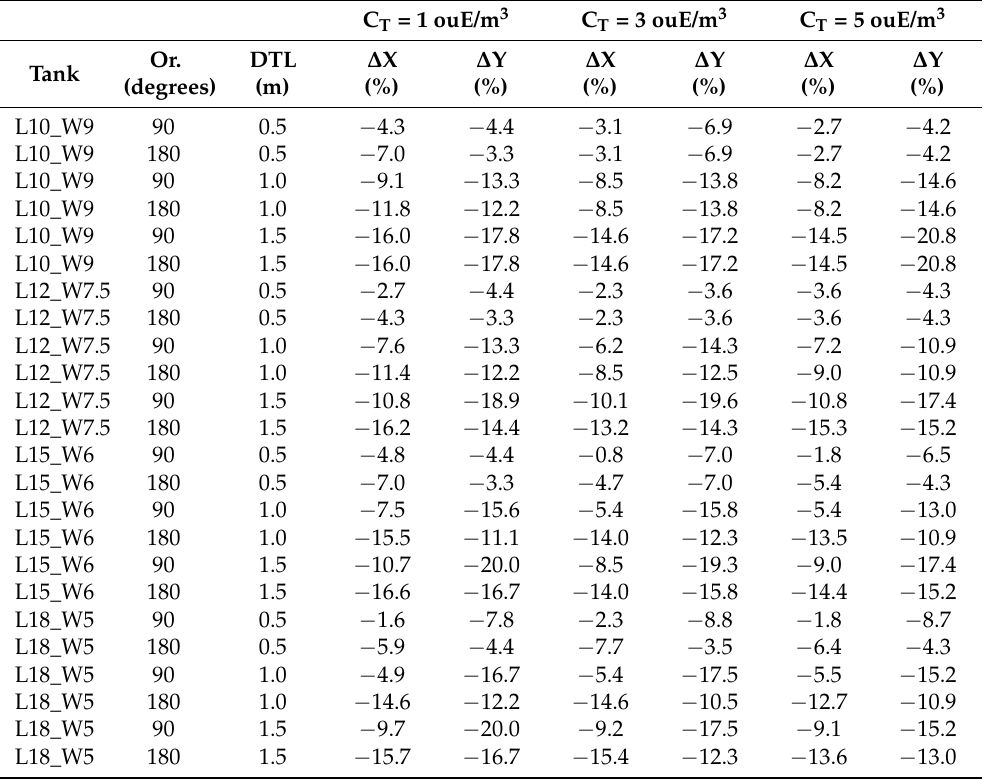
Table 7. Relative variation (%) of the maximum separation distances along X and Y as a function of the DTL. Or. is tank orientation.